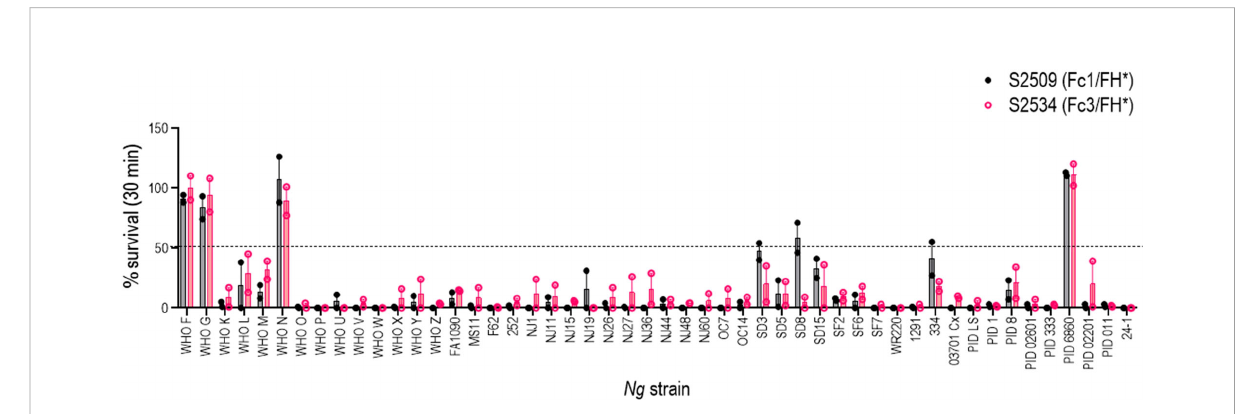
FIGURE 5 Complement-dependent bactericidal activity of S2509 (Fc1/FH*) and S2534 (Fc3/FH*) against a panel of 50 strains of N. gonorrhoeae . Fifty strains of N. gonorrhoeae (listed on the X-axis; see Supplemental Table S1 for a description of strains) were incubated with the fusion proteins (33 µg/mL) and human complement (IgG and IgM depleted human serum; fi nal concentration 10%). Bacterial survival at 30 min relative to 0 min is indicated as a percentage on the Y-axis. The mean (range) of two separate experiments is shown. Complement alone did not result in any killing of any strain (survival >100%) (data not shown).